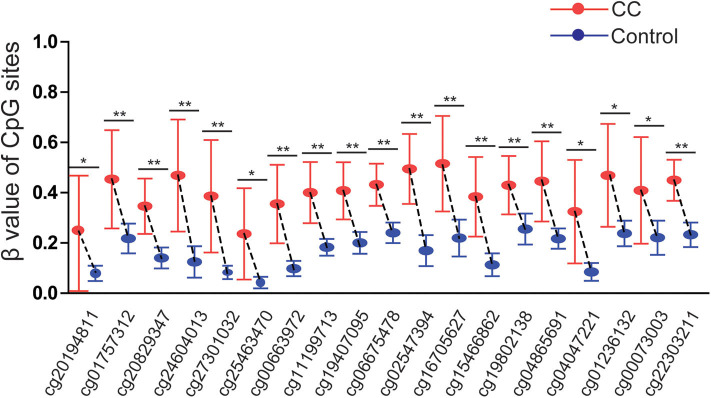
Significant differences in 19 CpG sites of SOX1 between cervical cancer and controls in TCGA and GEO dataset. P-value were calculated by the Mann–Whitney U-test. **P < 0.001,*P < 0.05.